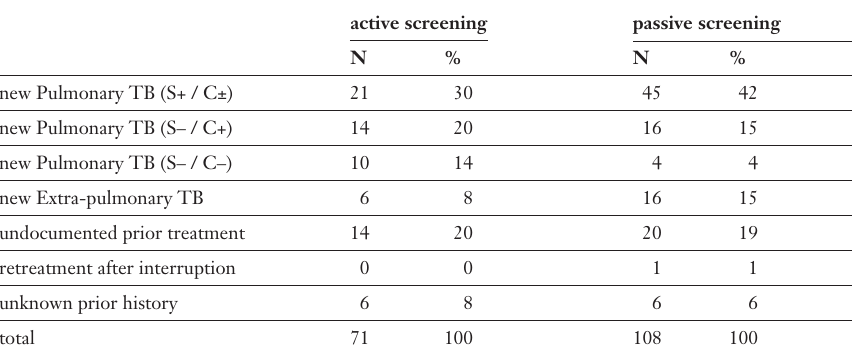
Category of TB, by screening procedure. S: Sputum smear, C: sputum culture.